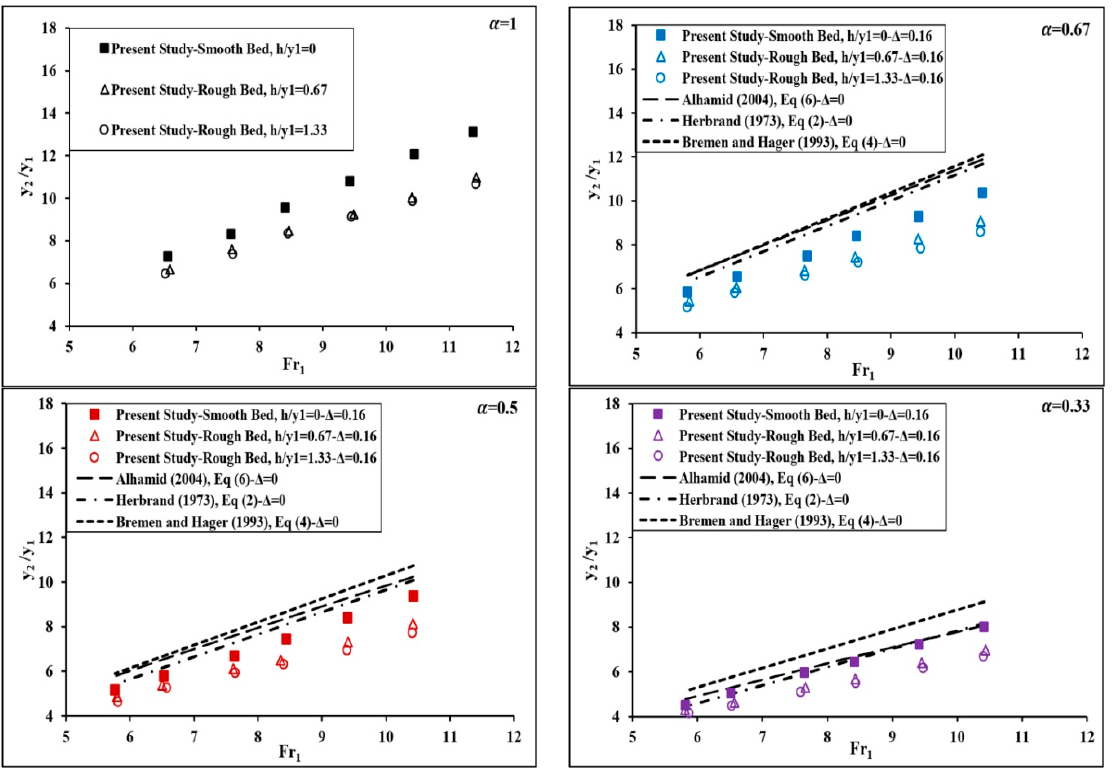
Figure 6. Sequent depth ratio as a function of upstream Froude number for two relative roughness heights ( h / y 1 = 0.67 and 1.33) and di ff erent expansion ratios ( α = 0.33, 0.5, 0.67, 1) with asymmetry ratio of ∆ = 0.16.